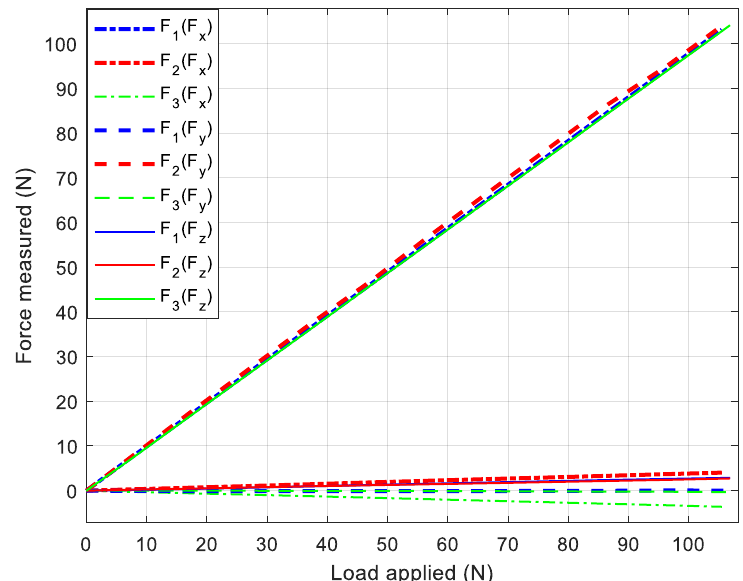
Figure 4. Calibration plot for system with locknut collars.